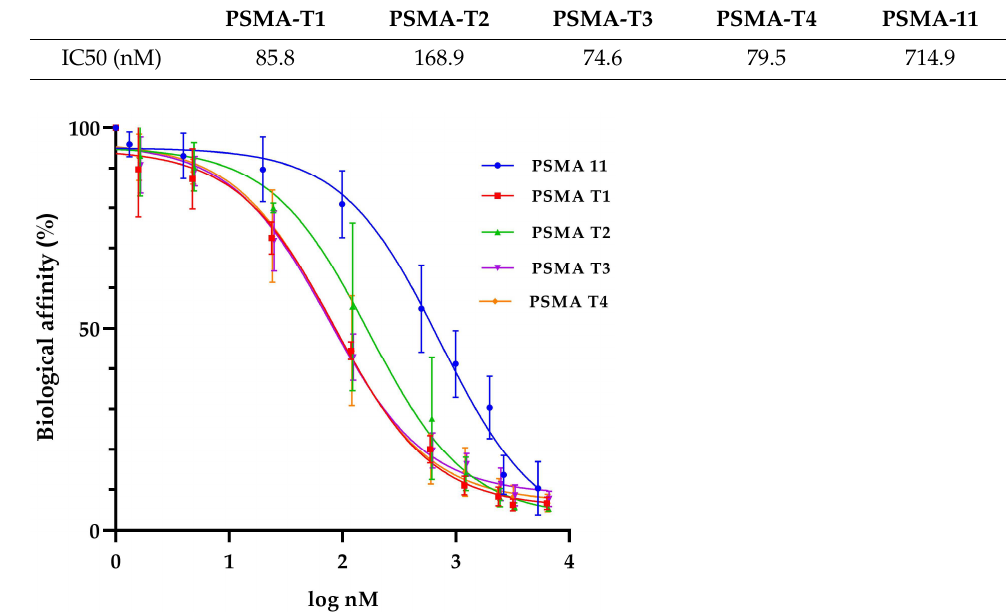
Table 4. The K d values and specific binding of the PSMA inhibitors were determined in the saturation binding assay. PSMA inhibitor